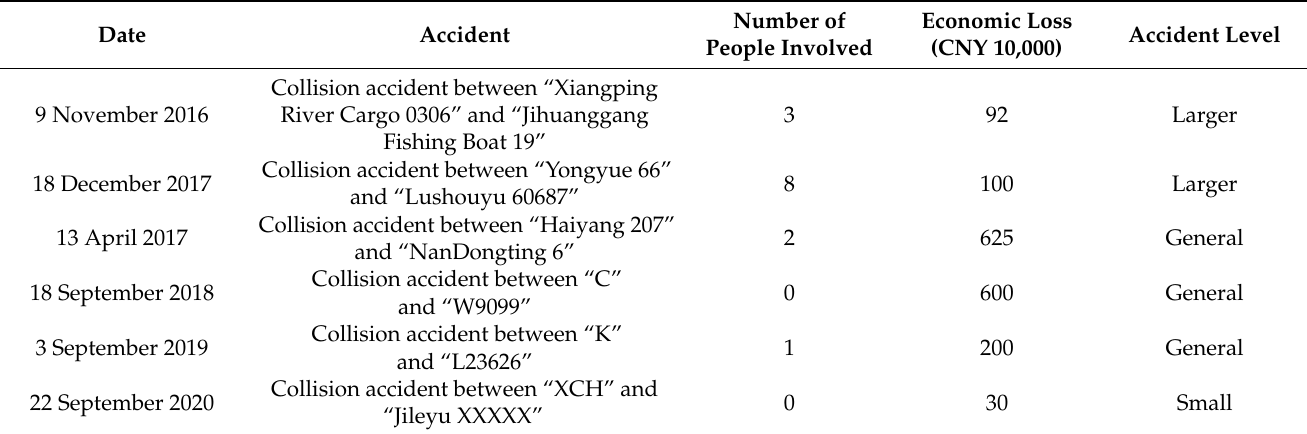
Table 2. Information on some historical cases in the Bohai Sea area (data source: Maritime Safety Administration of the People’s Republic of China).